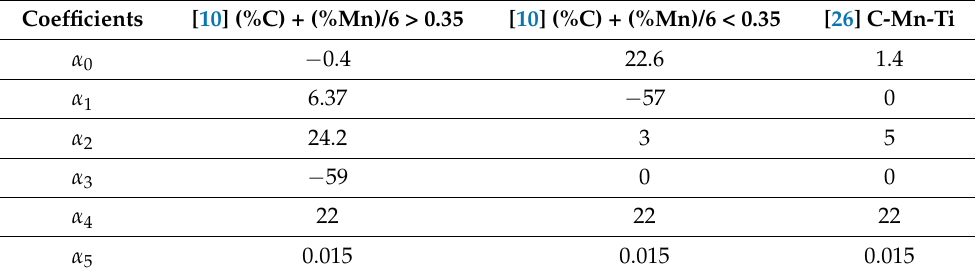
Table 6. Parameters used to calculate ferrite grain size for C-Mn steel.